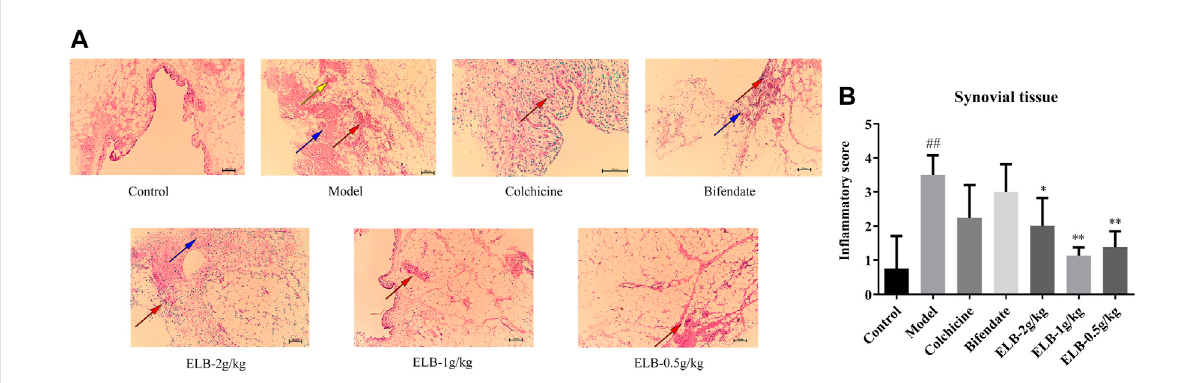
FIGURE 3 Histopathological evaluation showing the effects of ELB on synovial tissue in rats with chronic alcoholic liver injury and gouty arthritis. Representative images (A) . Histopathological quantitative score (B) . The red arrow indicates eosinophilic degeneration, yellow arrow indicates obvious vascular congestion, blue arrow indicates the scattered cell